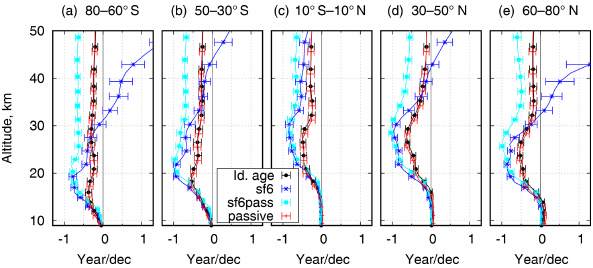
Figure 12. Vertical profiles of the simulated age of air linear trends over 11 years (2002–2012) for example latitude